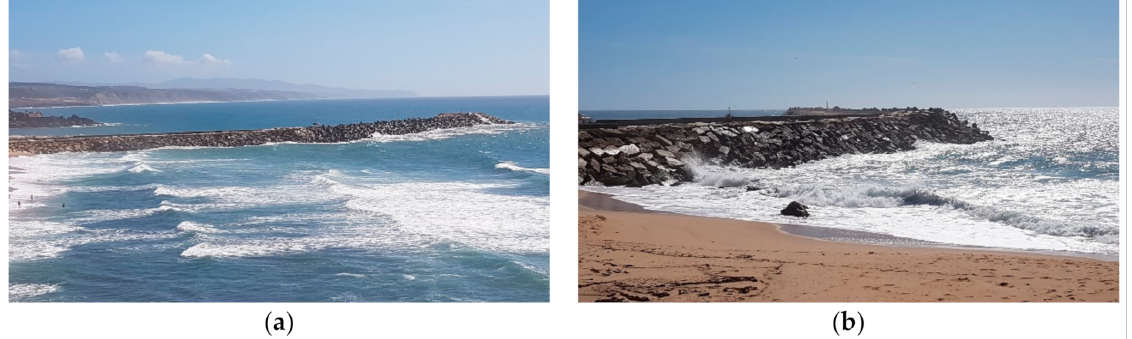
Figure 2. Some views of Ericeira breakwater: ( a ) panoramic view; and ( b ) the view from the base.